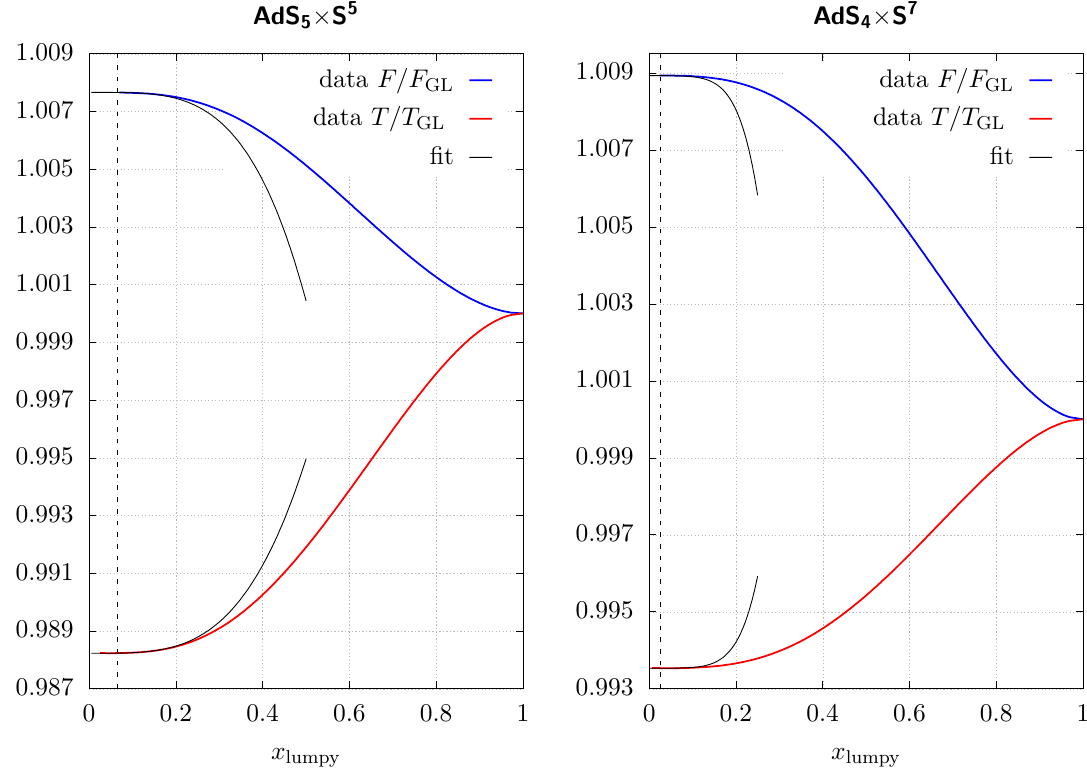
Figure 15. Normalized free energy (blue) and temperature (red) as a functions of x lumpy for ‘ = 1 lumpy black holes in AdS q . Data points to the left of the dashed vertical line are the ones used p × S for the fit (in black). Other thermodynamic quantities such as the entropy or the energy exhibit a similar